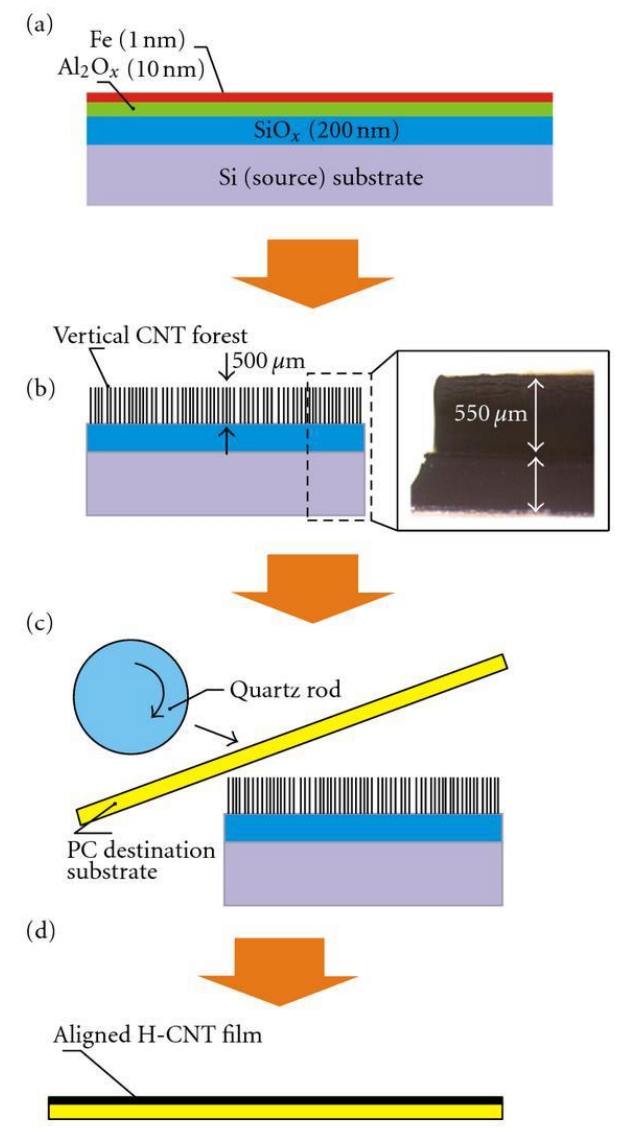
Figure 5. Schematic of the substrate transfer technique of MWCNT film synthesis [33]. Starting substrate sputtered with Fe and Al 2 O x ( a ). MWCNTs synthesized on the starting substrate with CVD ( b ). Final substrate aligned and pressed against grown MWCNTs ( c ). Final CNT film on target substrate ( d ). Used with permission from Hindawi.